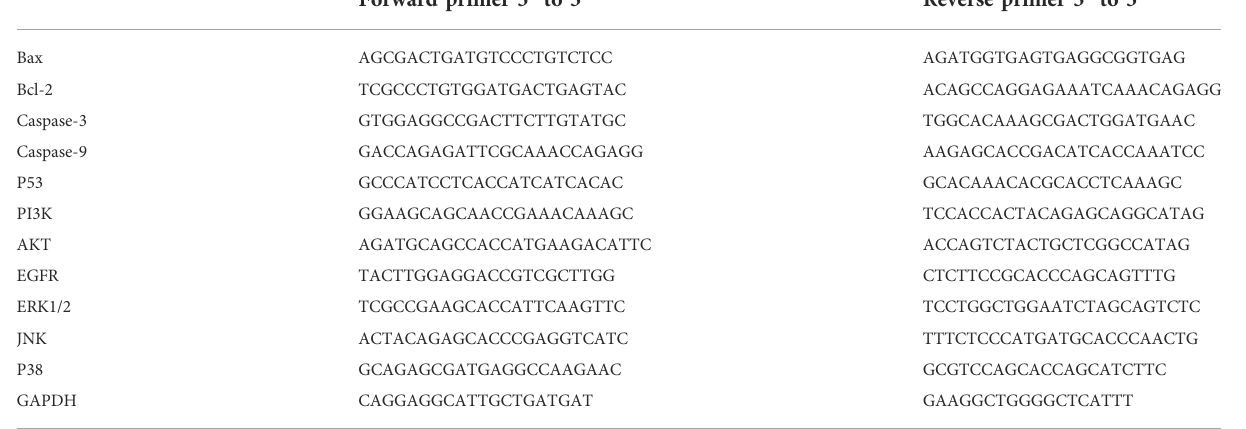
TABLE 1 Sequences of real-time polymerase chain reaction (RT-PCR)